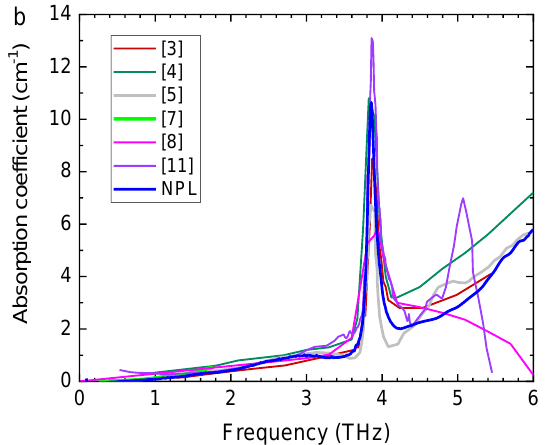
Figure 5. THz optical parameters for the ordinary ray transmission in quartz crystal. Data reported in the literature are shown together with the results of this work. ( a ) refractive index; ( b ) absorption coefficient.